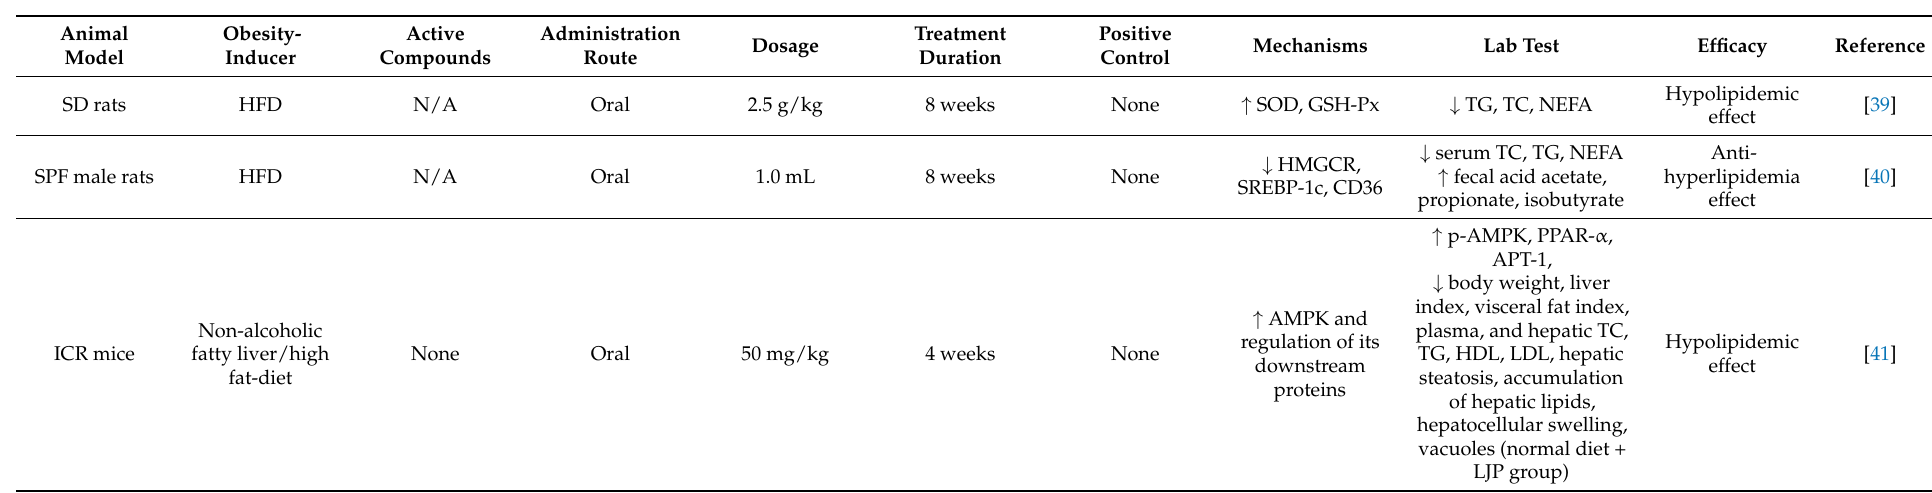
Table 4. An overview of the included in vivo studies on the efficacy of LJP on